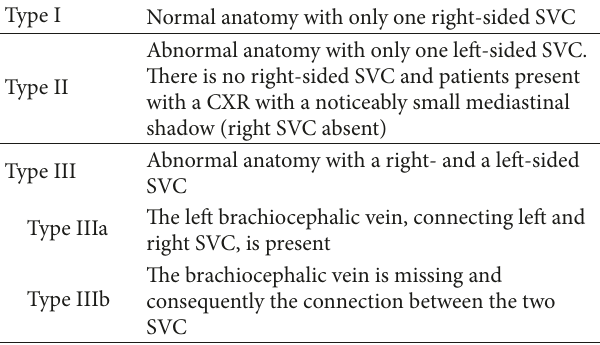
Table 1: Upper vena cava morphology (SVC)